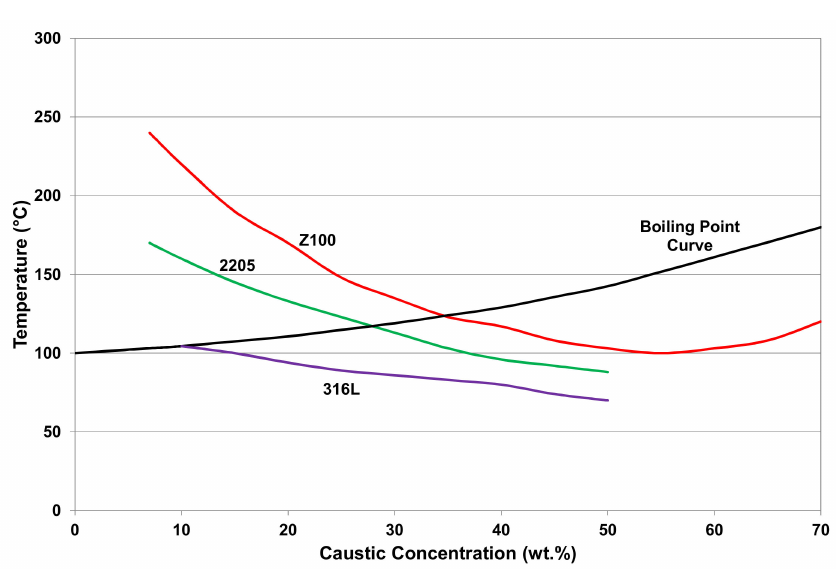
Figure 17. Iso-corrosion curves (0.1 mm/y) for some stainless steels in caustic soda